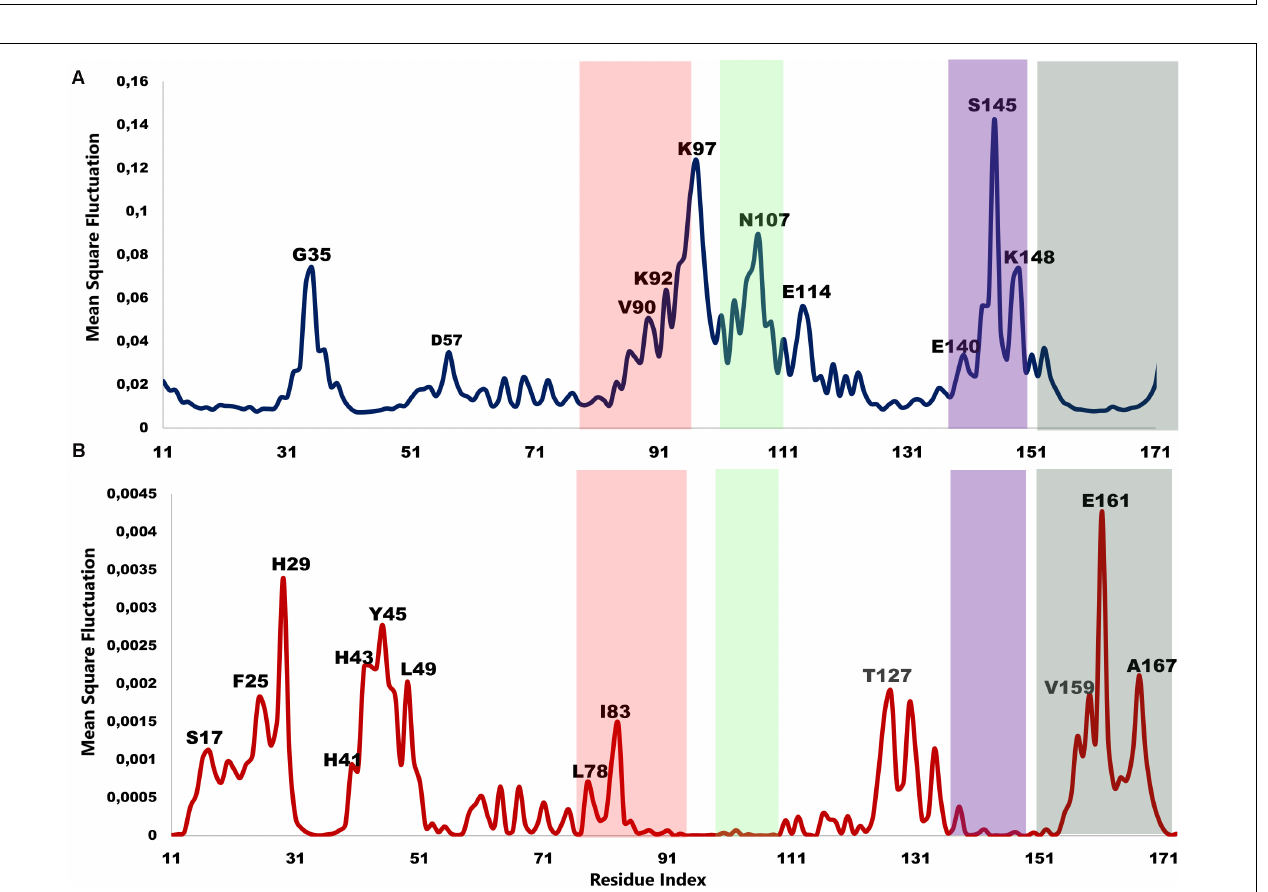
FIGURE 8 | The MEME sequence logo contains a stack of letters at every position in the motif. The height of the letters represents the probability (in bits) of the letter occurring at that position multiplied by the number of times that residue occurs within that site in each motif site in the total dataset (Bailey et al., 2015).